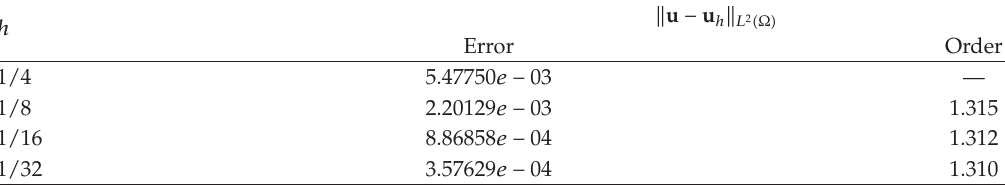
Table 4: L 2 -error and order of convergence in x when μ (cid:8) 1 .